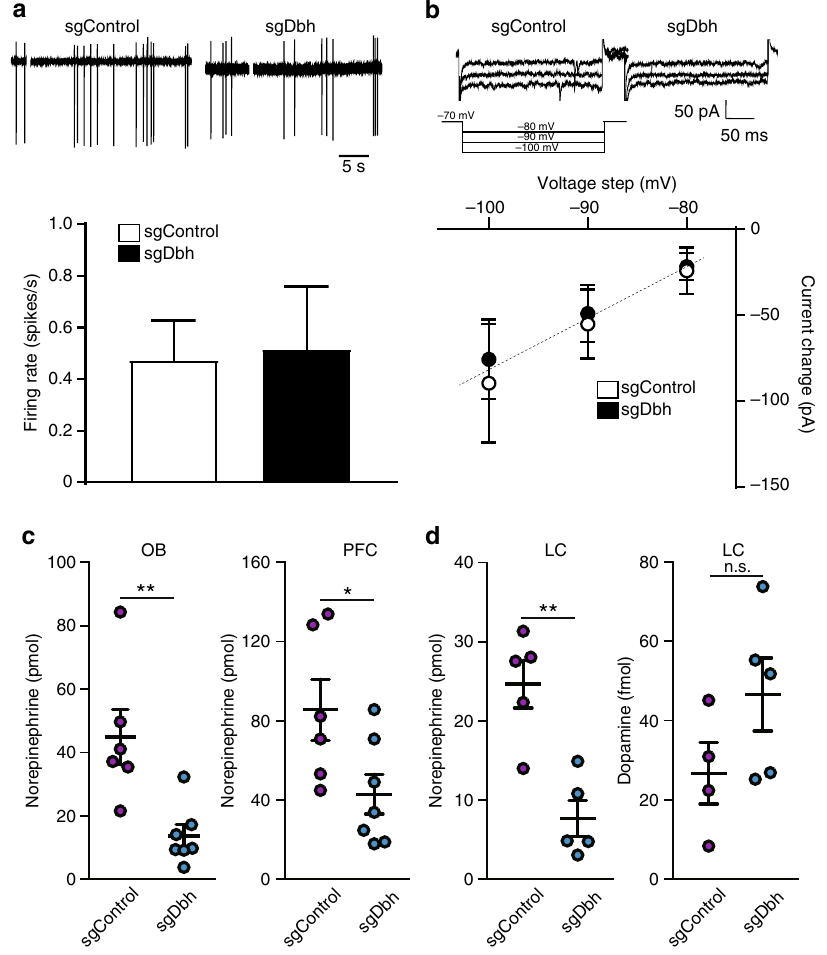
Fig. 2 Excitability and neurotransmitter productions of dbh -disrupted LC neurons. a , b Firing rate ( a ) and the current clamp recordings ( b ) of the LC cells. The horizontal brain slices containing LC were prepared from the mice bilaterally injected with AAV-DJ sgControl or AAV-DJ sgDbh. The recordings were performed with 7 cells/3 animals (sgControl) and 8 cells/3 animals (sgDbh), respectively. c Quanti fi cation of norepinephrine in brain homogenates. The olfactory bulb (OB; left panel) or prefrontal cortex (PFC; right panel) were removed from the mice bilaterally injected with AAV-DJ sgControl ( n = 6) or AAV-DJ sgDbh ( n = 7). (* P < 0.05, ** P < 0.01 by two-tailed Student t -test between sgControl and sgDbh; t = 3.516 (OB) and 2.382 (PFC), d f = 11 (OB) and 11 (PFC)). d Quanti fi cation of norepinephrine (left panel) and dopamine (right panel) in the LC. The LC was removed from the mice unilaterally injected with DJ sgControl ( n = 4 – 5) or AAV-DJ sgDbh ( n = 5). (** P < 0.01 by two-tailed Student t -test between sgControl and sgDbh; t = 4.512 (norepinephrine) and 1.601 (dopamine), d f = 8 (norepinephrine) and 7